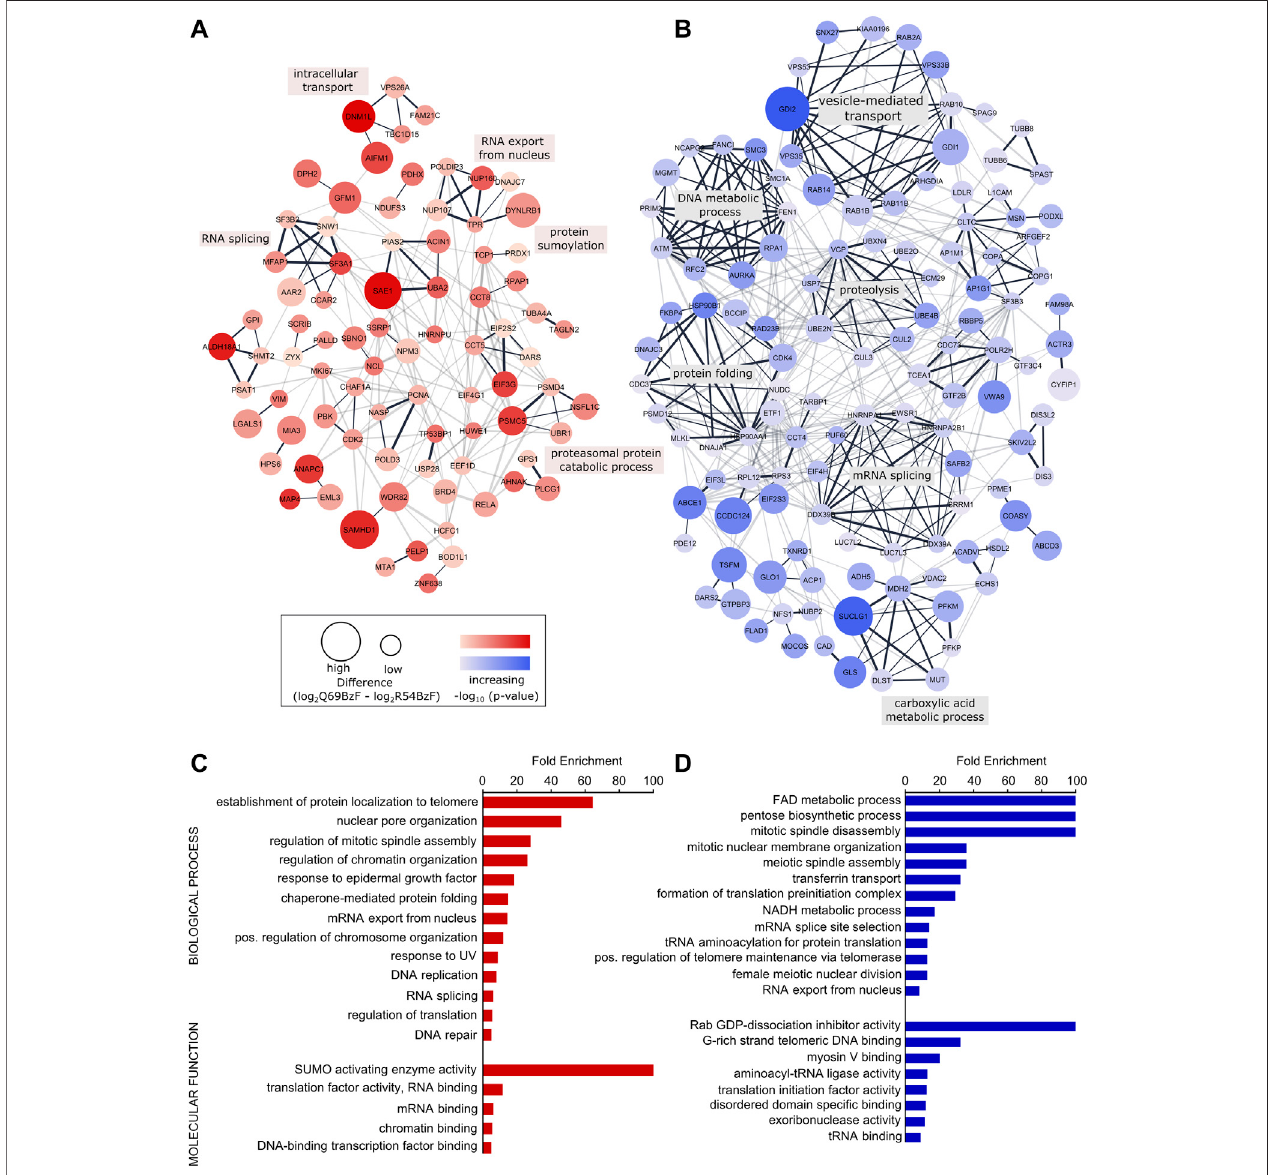
FIGURE 5 | Analysis of identi fi ed SUMO-1 (R54BzF) and SUMO-1 (Q69BzF) interactors. (A) and (B) STRING network analysis and MCL clustering of proteins signi fi cantly enriched by SUMO-1 (R54BzF) (red) and SUMO-1 (Q69BzF) (blue) probes, respectively. Nodes are sized according to differences determined by Student ’ s t-test, which correspond to enrichment compared to the respective other SUMO-1 probe. Color intensities represents – log10 ( p -value). Only connected nodes are visualized. In the chase of the SUMO-1 (Q69BzF) probe only clusters with three or more proteins are visualized. Edge thickness corresponds to combined scores from STRING. MCL cluster edges are presented in black. Most signi fi cant biological process were annotated for large MCL clusters (see also Supplementary Table S3 ). (C) and (D) Overrepresentation analysis of Gene Ontology (GO) terms of biological processes and molecular functions compared to the whole human genome, as derivedfromtheSUMO-1(R54BzF)(red)andSUMO-1(Q69BzF)(blue)datasets,respectively.UsingPANTHERwithFisher ’ sExacttestonlyGOtermswithFDR p -value < 0.05 were considered as signi fi cant. For complete list, see Supplementary Table S4